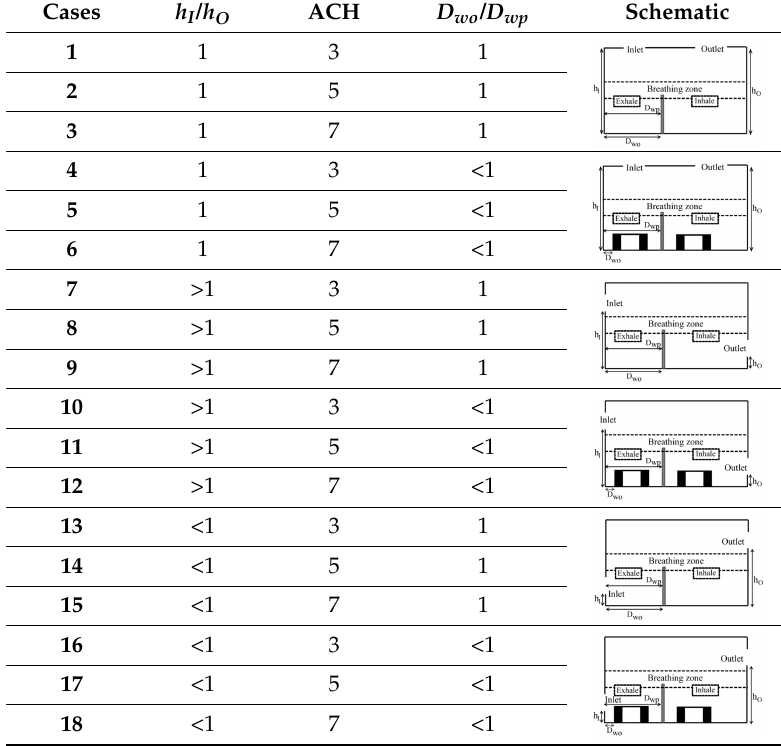
Table 1. Dimensional configuration of the 18 cases simulated. ACH—air changes per hour. Cases